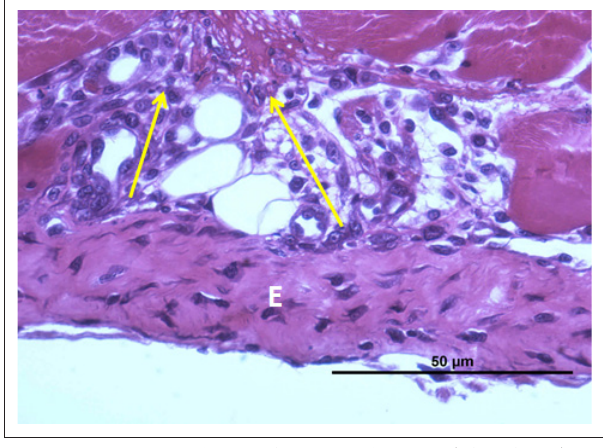
FIGURE 2: Phosphotungstic haematoxylin stain showing swollen and rounded myofibres at the periphery of the non-vascular, cellular matrix.